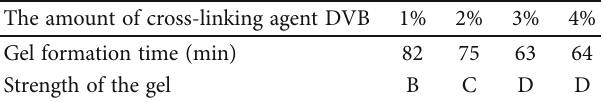
Table 4: The in fl uence of cross-linking agent DVB on gel.